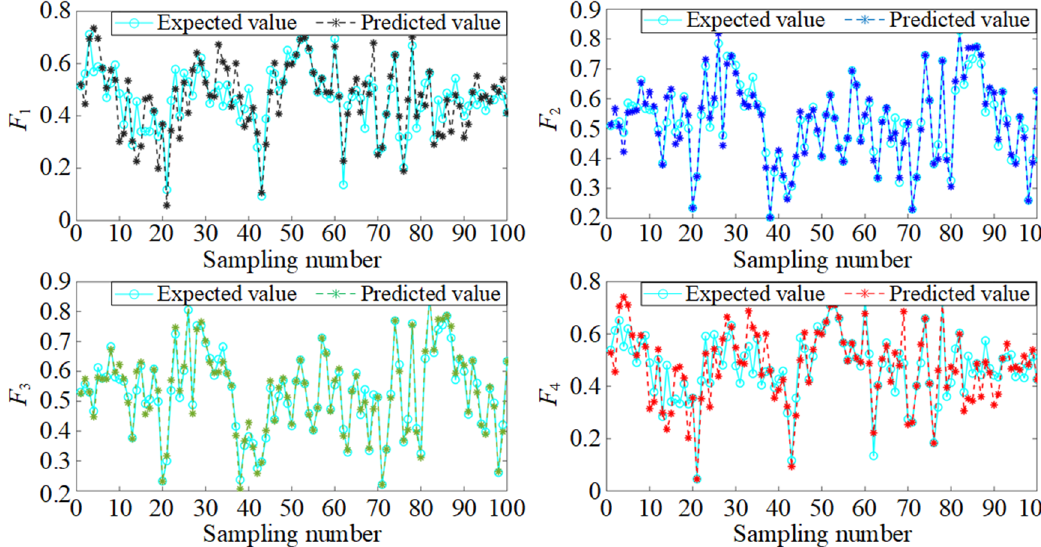
Fig. 17. Comparison between predicted value and expected value.